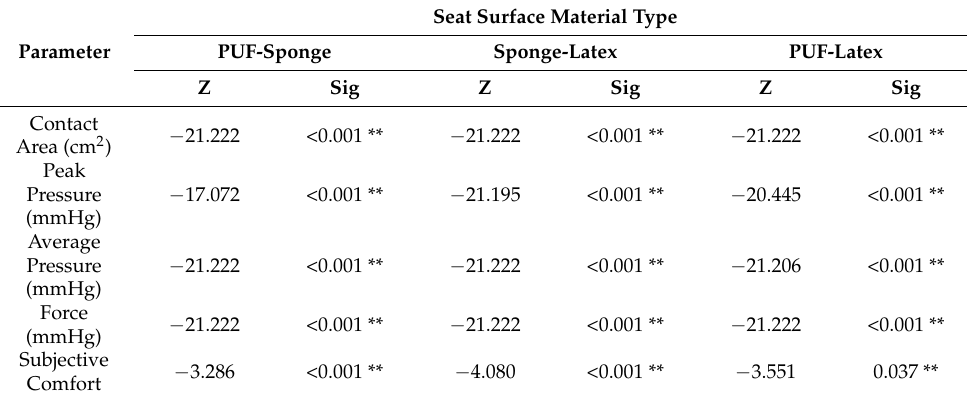
Table 4. After pairwise evaluation of seat surface material